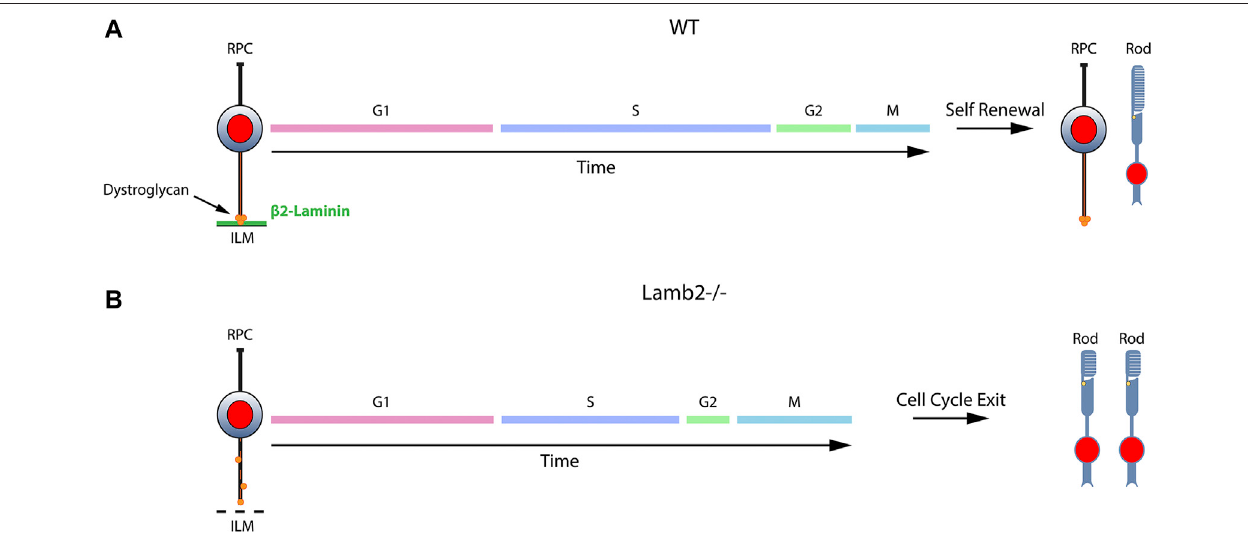
FIGURE 7 | β 2-containing laminins govern RPC proliferation by modulating the cell cycle dynamics via DG. Contact between RPCs and the ILM is maintained throughout the cell cycle via a variety of receptors. The signaling cascades modulated by these receptors play important roles in controlling the cell cycle dynamics and the ensuing cell fate. (A) . DG mediates the signaling between RPCs and β 2-containing laminins in the ILM. Cells progress through cell cycle and proceed to divide in a self-renewingfashion,maintainingproperprogenitorpool,orexitthecellcycletoproduceretinalneurons. (B) .Lossoflaminin β 2leadstodisruptedILM,whichfails to provide proper binding sites to DG. This leads to mislocalization of the receptor and alters its molecular signaling pathways. As a result, RPC cell cycle dynamics are altered, and the resulting mitoses lead to premature cell cycle exit with overproduction of rods and premature progenitor pool depletion.